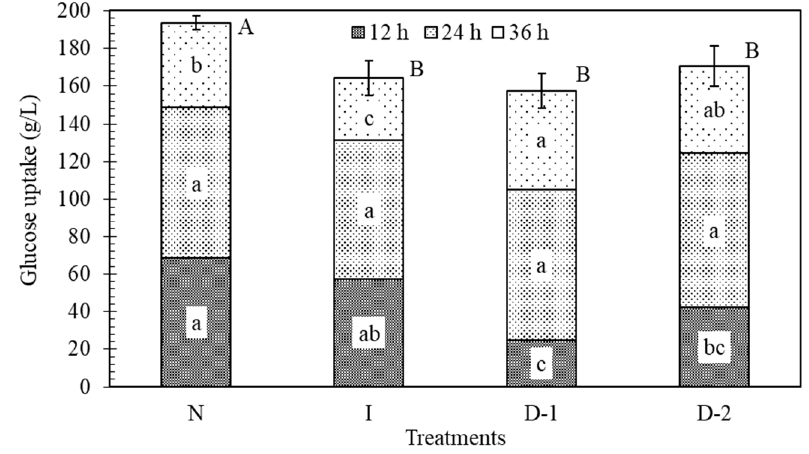
Figure 4. Effect of ultrasound on glucose uptake (g/L) during fermentation at different time periods. Each total bar height indicates the amount of glucose consumed in 36 h. Shaded sections indicate amounts used during 12 h periods. Each texture pattern and treatment contain the result of the Tukey–Kramer HSD test, α = 0.05; lower case letters indicate significance of differences among treatments at the same time range; capital letters indicate differences among the total glucose uptake between treatments. The error bars indicate the standard deviation. No-ultrasound (N), indirect ultrasound (I), direct ultrasound 1 (D-1), and direct ultrasound 2 (D-2).